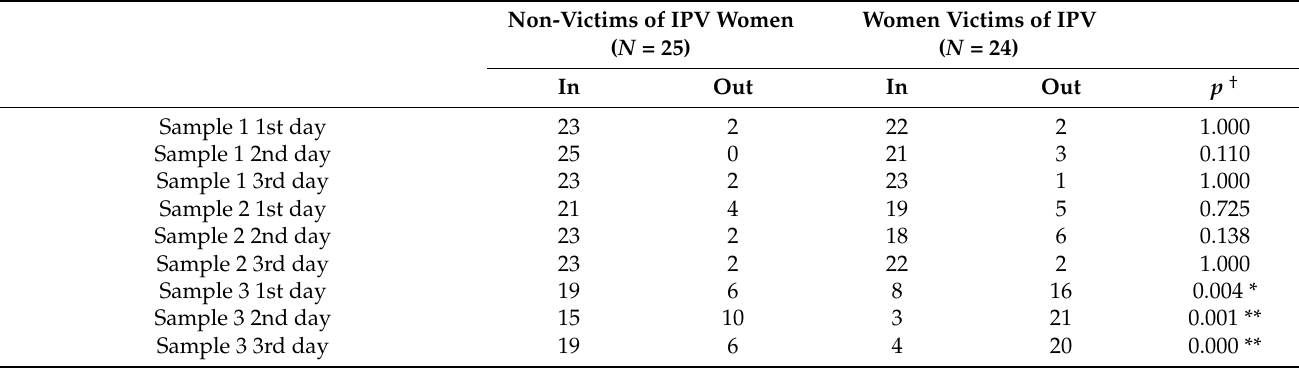
Table 4. The number of women with saliva cortisol levels within or outside the maximum percentiles as compared to the CIRCORT database, according to the sample collection and